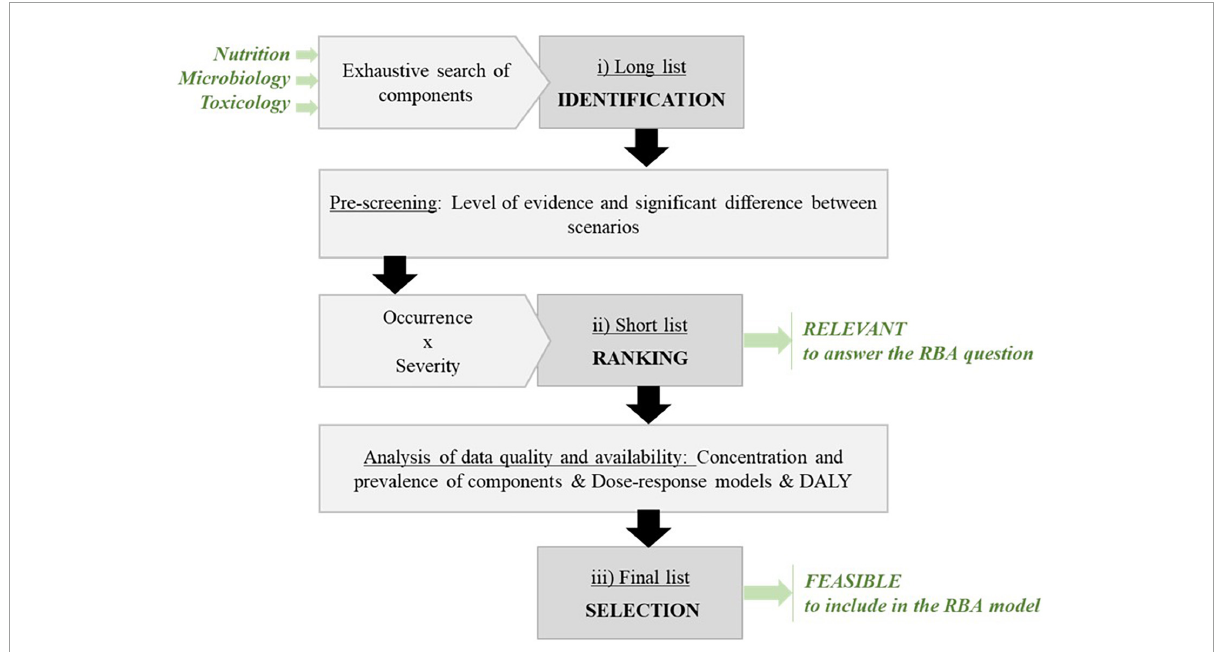
FIGURE2 Scheme of key steps applied to establish a “long”, “short”, and “final” list of